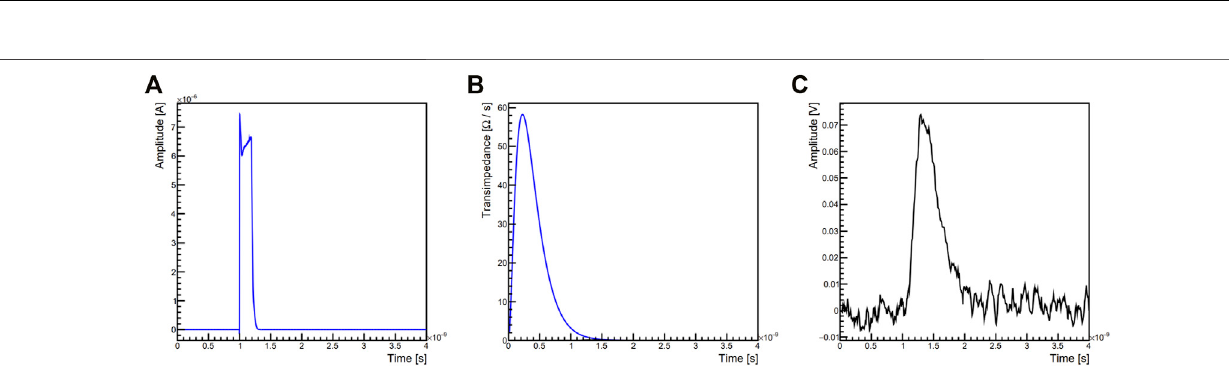
Frontiers in Physics |